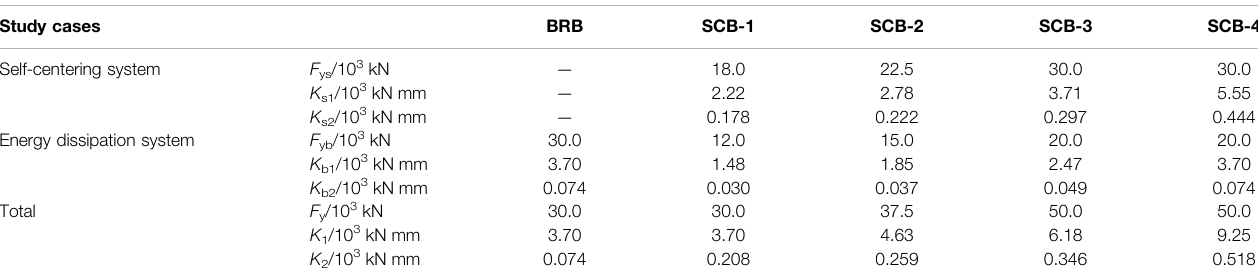
TABLE 3 | Performance parameters of the web members of the study